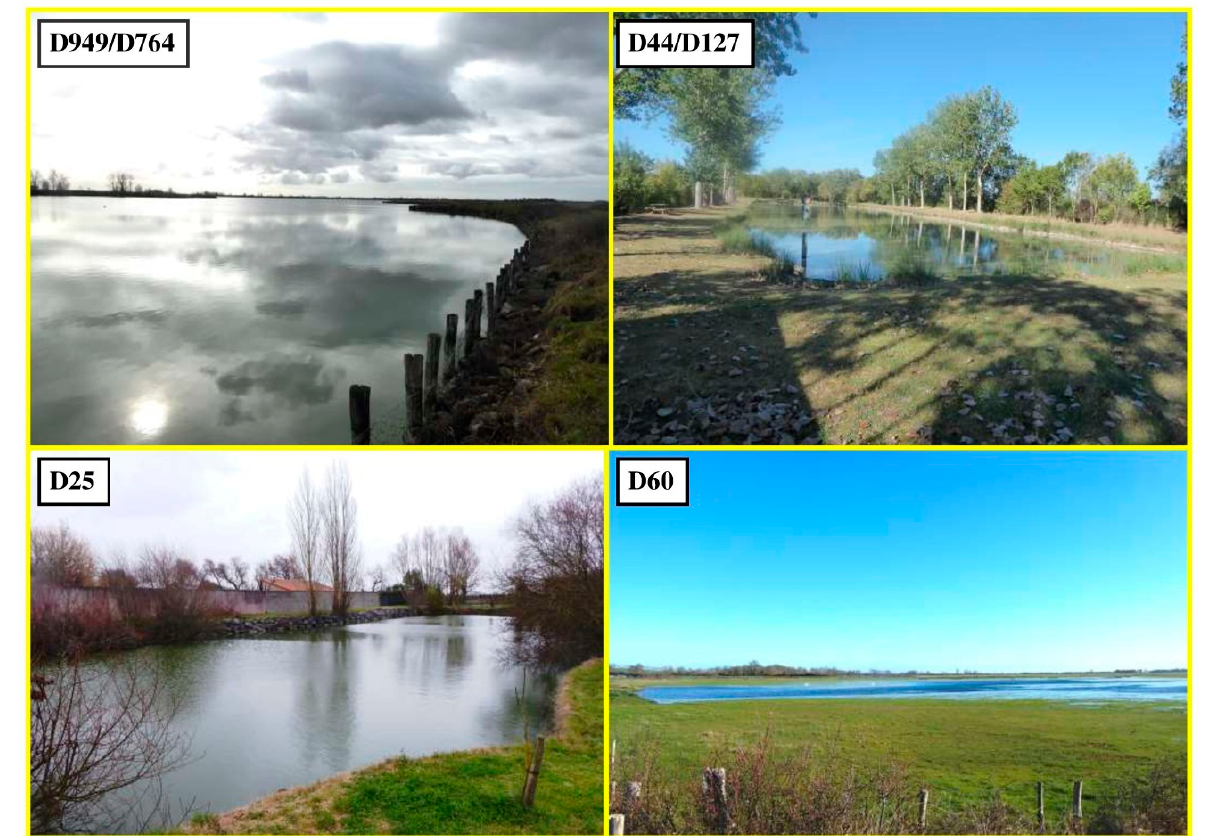
Figure 3. Examples of toad breeding ponds in the study area labelled with road numbers where mortalities from crossings were found.